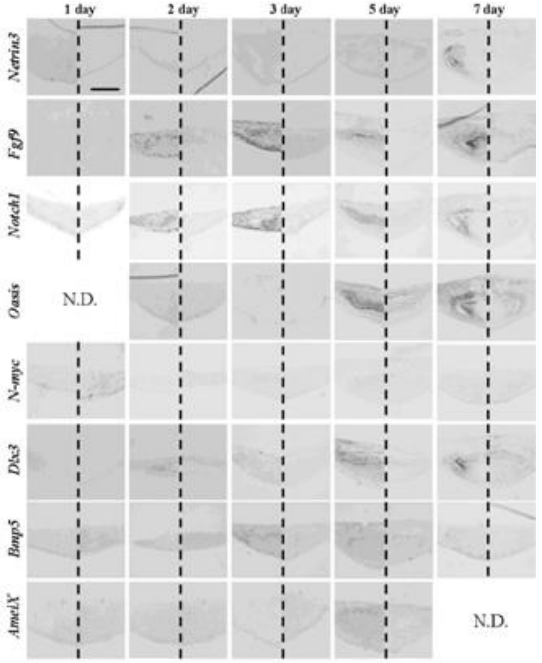
Figure 8. Gene expression pattern in germs reconstructed with EC and MT (positive control). Gene expressions were examined with in-situ hybridization with antisense probe in left and sense probe in right of each panel. Germs were cultured on inserts for one to seven (cid:71)(cid:68)(cid:92)(cid:86)(cid:17)(cid:3)(cid:54)(cid:70)(cid:68)(cid:79)(cid:72)(cid:3)(cid:69)(cid:68)(cid:85)(cid:3)(cid:76)(cid:86)(cid:3)(cid:21)(cid:19)(cid:19)(cid:3)(cid:541)(cid:80)(cid:3)(cid:68)(cid:81)(cid:71)(cid:3)(cid:68)(cid:79)(cid:79)(cid:3)(cid:73)(cid:76)(cid:74)(cid:88)(cid:85)(cid:72)(cid:86)(cid:3)(cid:68)(cid:85)(cid:72)(cid:3)(cid:68)(cid:87)(cid:3)(cid:87)(cid:75)(cid:72)(cid:3)(cid:86)(cid:68)(cid:80)(cid:72)(cid:3)(cid:80)(cid:68)(cid:74)(cid:81)(cid:76)(cid:73)(cid:76)(cid:70)(cid:68)(cid:87)(cid:76)(cid:82)(cid:81)(cid:17)